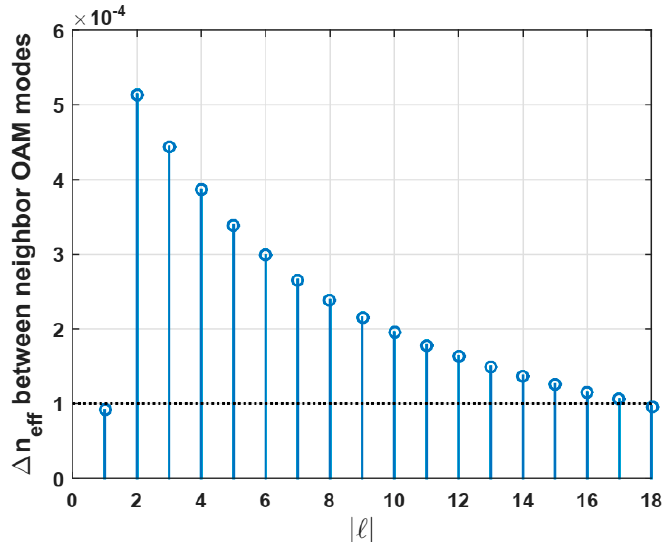
Figure 3. Splitting of n e f f between neighbor OAM modes at a telecom wavelength of λ = 1300 nm. The spatial phase distribution given by the term e ± il φ for stable OAM modes with l = ± 10, ± 14 and ± 17 was also computed (see Figure 4). The spatial phase distributions repeating each 2 π (from −π to π ) indicate the presence of a component of momentum ( p ) in azimuthal direction ( φ ), responsible for the orbital angular momentum and the propagation of OAM modes.